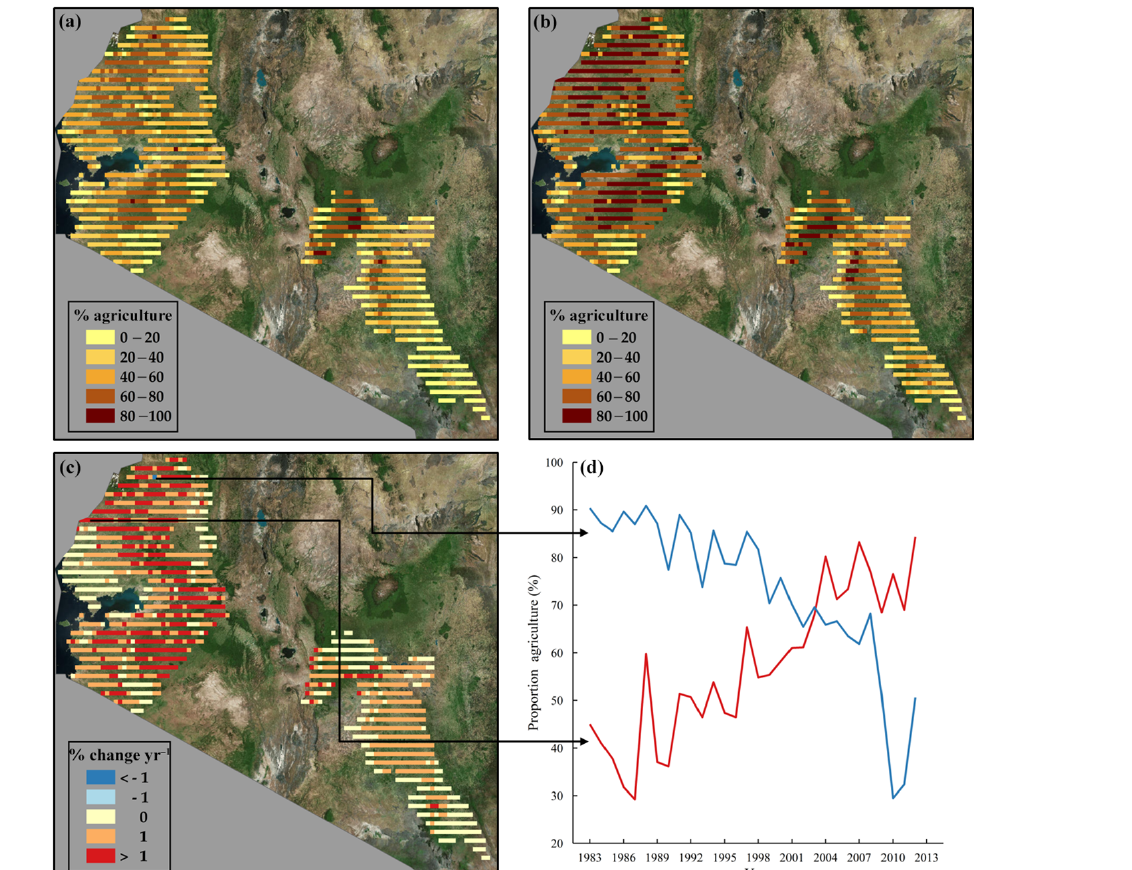
Figure 10. Simulated percent agriculture for sample area frames in 1983 (a) and 2012 (b) , change in agriculture per year over the 30 year (1983–2012) period (c) , and time series of the strongest positive (red) and negative (blue) trend (d) . Trends were determined with a Theil–Sen estimator and masked for significance using the Man–Kendall statistic at the 99.9% confidence